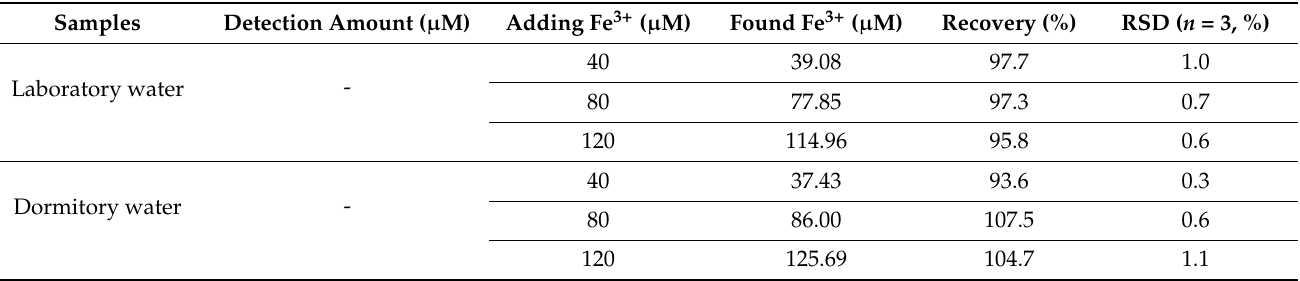
Table 1. Recovery of Fe 3+ in actual water